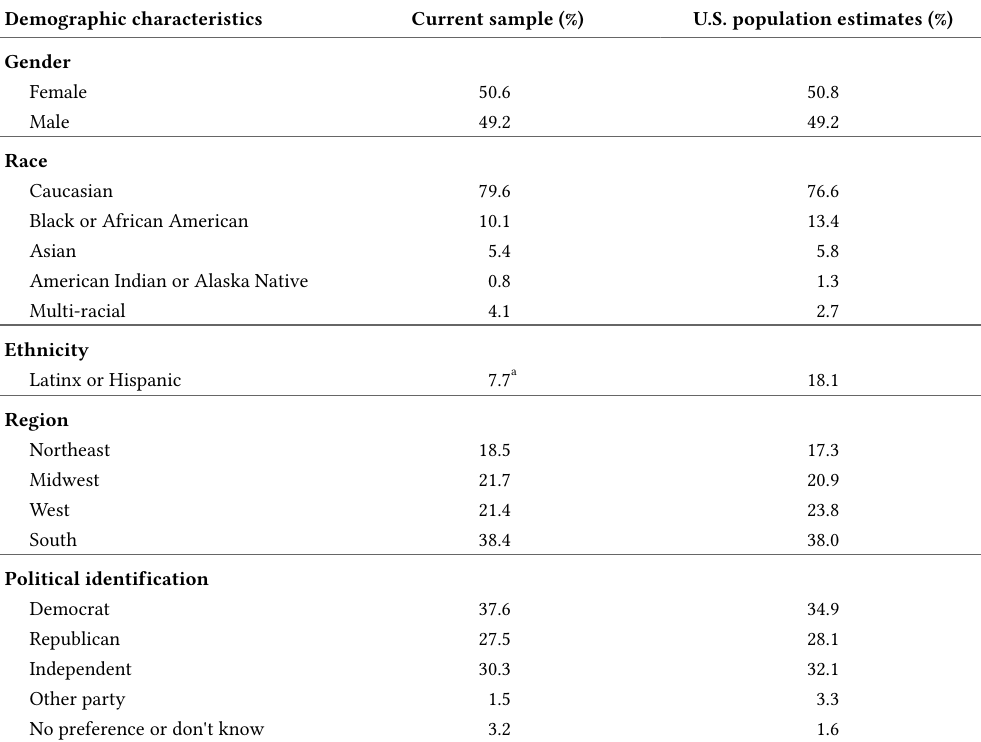
Description of the Current Sample (N = 852) With U.S. Population Comparison Data Demographic